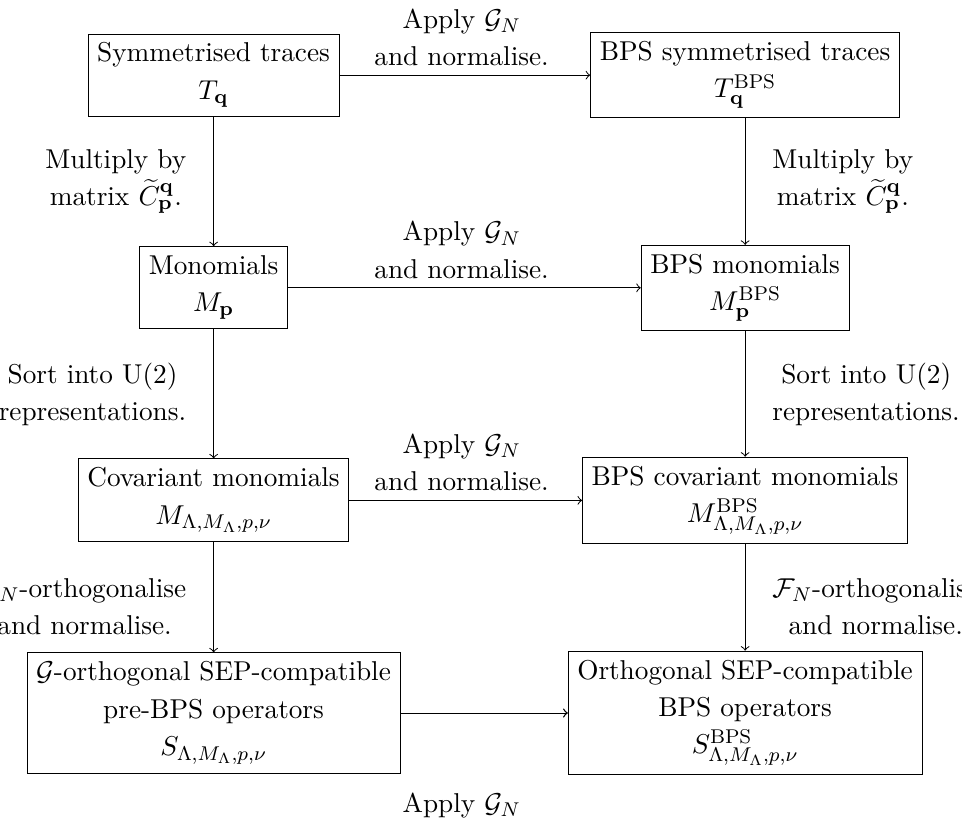
Figure 1 . An outline of the algorithm presented in this paper starting with symmetrised trace operators T and deriving a U(2) covariant, orthogonal, SEP-compatible basis S BPS p operators when N ≥ n . All normalisations are with respect to the S any algorithm to derive S BPS need only involve one normalisation step at the very end. The Λ ,M Λ ,p,ν extra normalisation steps are included in the figure in case the desired output is a different choice of BPS basis such as M BPS Λ ,M Λ ,p,ν